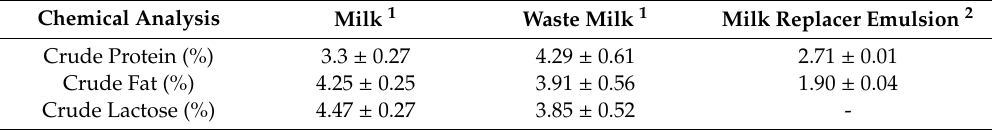
Table 2. Chemical analysis of the milk, waste milk and milk replacer emulsion.